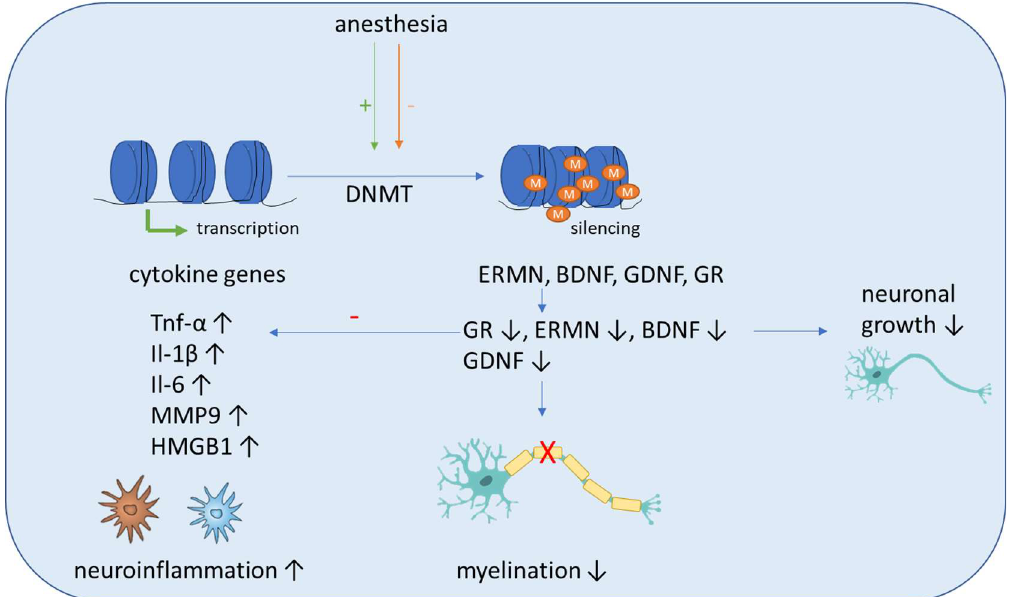
Figure 2. Schematic overview of the molecular mechanisms induced by anesthesia on DNA methylation. Anesthesia can cause both an increase and decrease of DNA-methyltransferase (DNMT) activity. The methylation of inflammatory genes (Tnf-α, IL-1β, Il-6, MMP9, HMGB1) is generally decreased, which leads to increased expression and aggravates neuroinflammation. Anti-inflammation is decreased by decreased expression of the anti-inflammatory transcription factor glucocorticoid receptor (GR). In addition, the methylation of genes associated with neuronal growth (BDNF, GDNF), differentiation and survival of existing neurons (ERMN) is increased, which reduces their expression and causes cognitive impairment due to demyelination and the reduced growth of neurons.